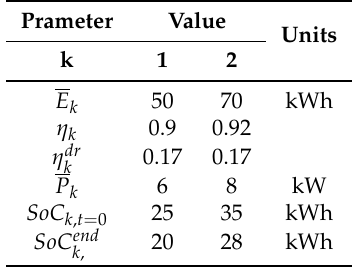
Table 1. General per vehicle input